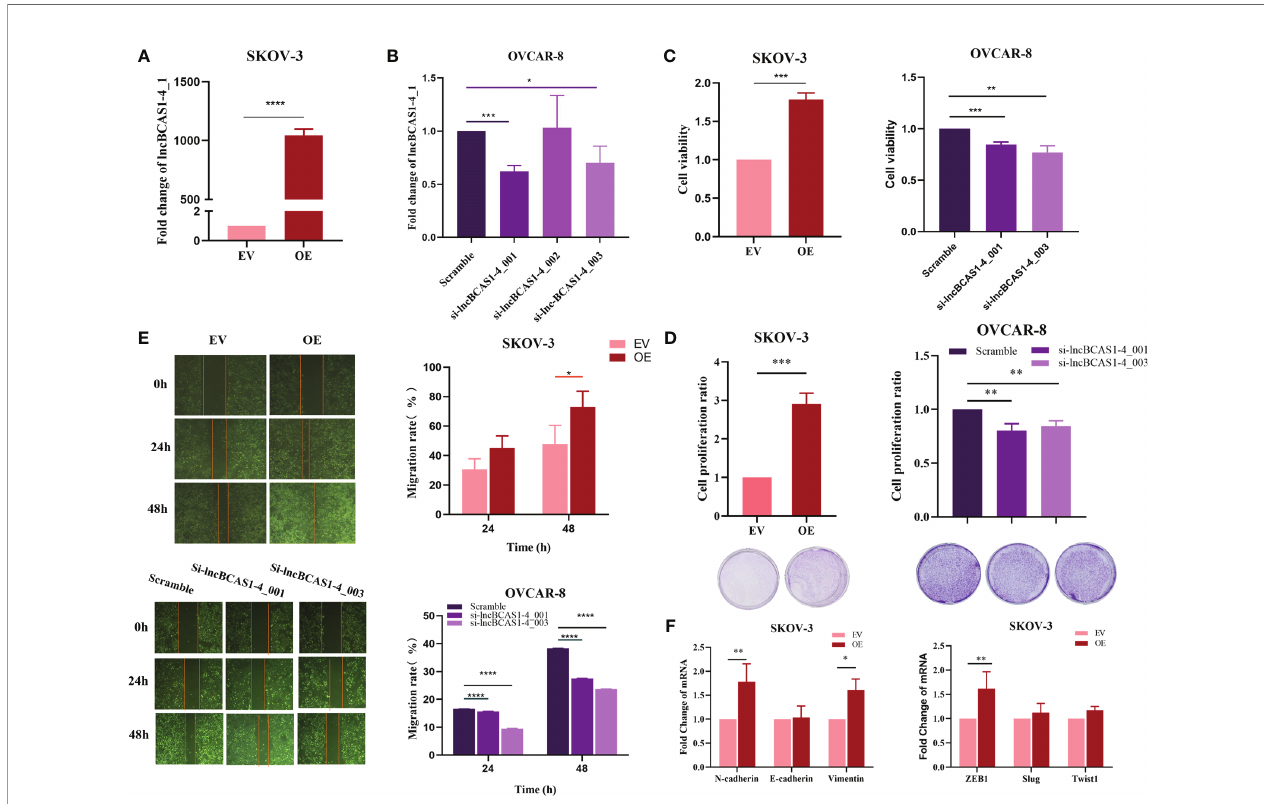
FIGURE 4 | Effect of lncBCAS1-4_1 on proliferation and migration in ovarian cancer cells. (A) Compared with empty vector control cells (EV), the expression of lncBCAS1-4_1 was upregulated in SKOV3 cells transfected by adenovirus (OE) for 72 h. (B) The level of lncBCAS1-4_1 was downregulated in OVCAR8 cells transfected by siRNA (sh-lncBCAS1-4_001 and sh-lncBCAS1-4_003) for 72 h, compared to scramble control. (C) The cell viability was detected by CCK-8 after cells were transfected for 72 h. (D) The proliferation activity was detected by colony formation assay after the cells were transfected for 72 h. (E) The migration capacity was measured by wound healing assay after the cells were transfected for 72 h. (F) The mRNA levels of EMT-related genes were determined using RT- PCR. * p < 0.05, ** p < 0.01, *** p < 0.001, **** p <